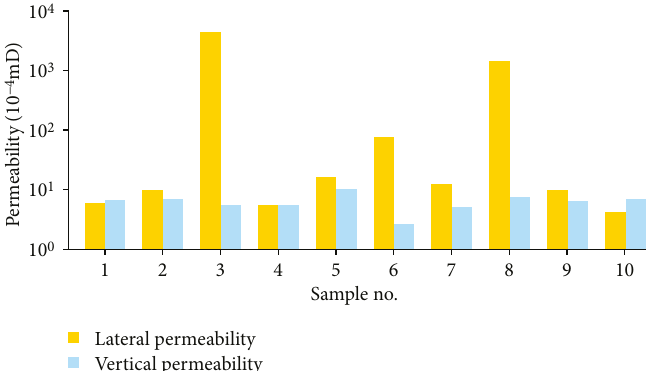
Figure 6: Lateral and vertical permeability of the lower Cambrian shale of Jiangye-1 and Jiangye-2. See Figure 1 for the well locations.